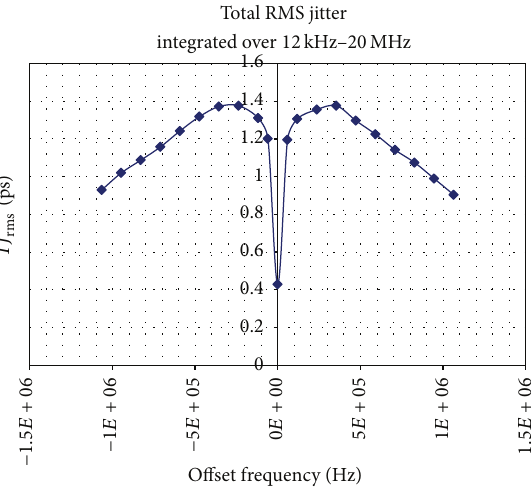
Figure 7: Measured total jitter of the victim CSU versus the offset frequency of aggressor link.